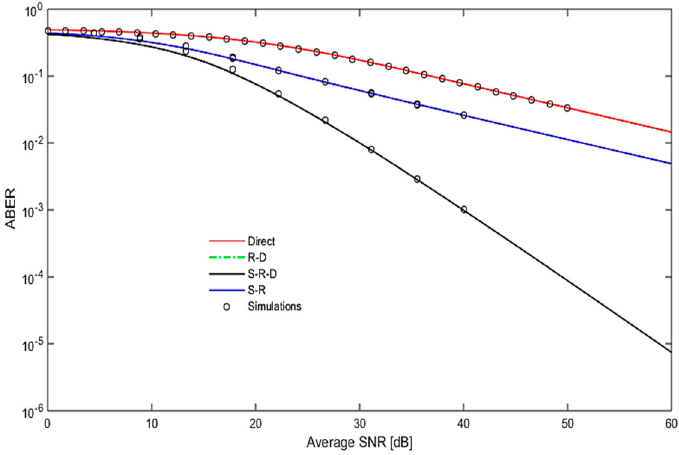
Figure 9. ABER vs. SNR of FSO over the L ‐ N channel for moderate turbulence with distance 500–500 m, the number of relays = 3, and wz = 0.5 m.